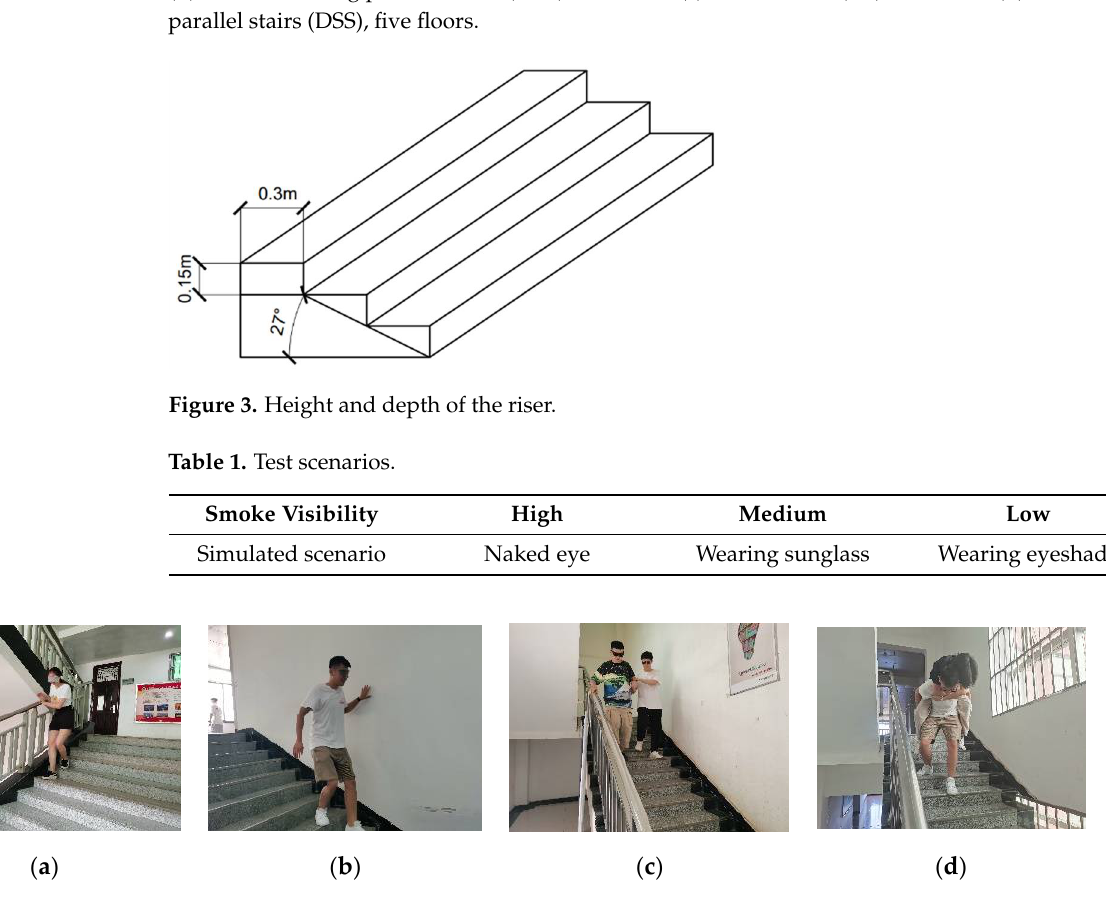
Figure 4. Photos at the test scene. ( a ) SF under low visibility; ( b ) SM under low visibility; ( c ) TM under medium visibility; ( d ) MC under medium visibility.